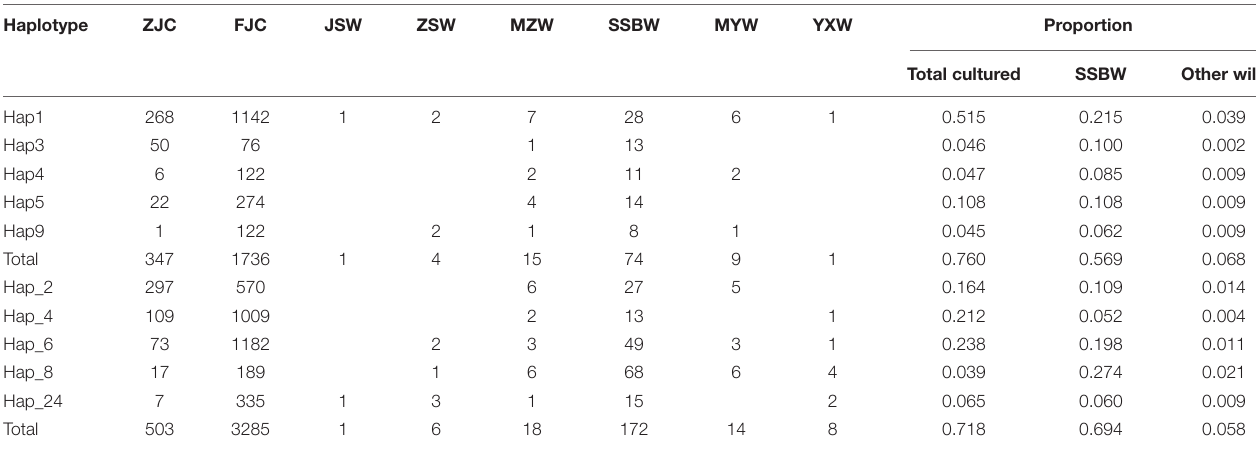
FIGURE 3 | Analysis of shared haplotypes between cultured and wild populations. (A,B) Show the results based on mtDNA, and (C,D) show the results based on the nuDNA. (B,D) Show the PIH and PSH of the total cultured and total wild populations. The proportion of individuals with shared haplotypes (PIH) is shown in orange, and the proportion of shared haplotypes (PSH) is shown in blue. The wild populations are ordered from north to south along the x -axis. TABLE 2 | The main haplotypes shared between cultured and wild